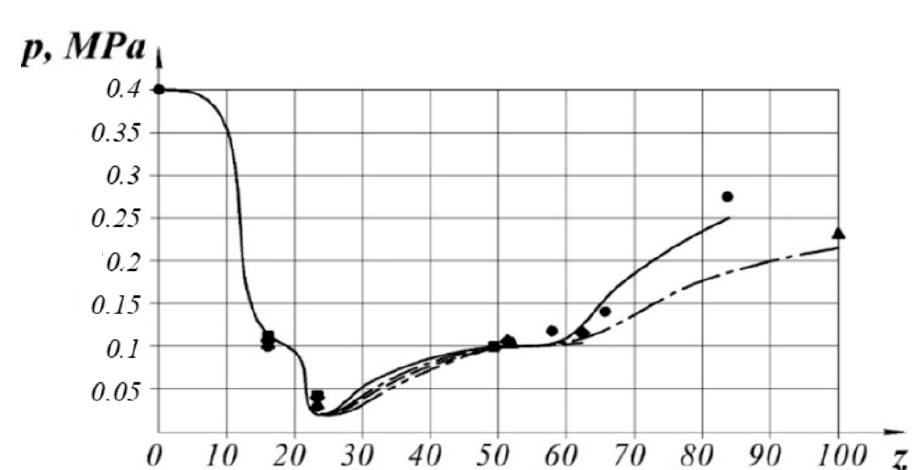
Figure 6. Pressure distribution along the length of the LVE flow path. Results of numerical research: ———for the design of the ejector presented on Figure 1a; - - - - —for the design of the ejector presented on Figure 1b; - · - · - —for the design of the ejector presented on Figure 1c; and - · · - · · - —for the design of the ejector presented on Figure 1d. Experimental data: • —for the design of the ejector presented on Figure 1a; (cid:117) —for the design of the ejector presented on Figure 1b; (cid:78) —for the design of the ejector presented on Figure 1c; and (cid:4) —for the design of the ejector presented on Figure 1d.